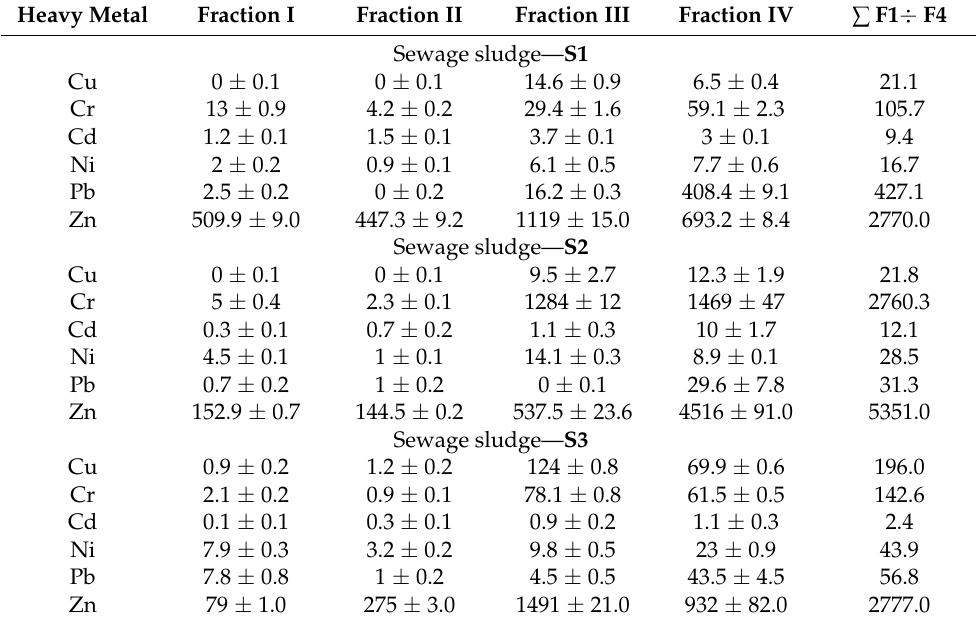
Table 8. Chemical speciation of heavy metal * in sewage sludge, mg · kg − 1